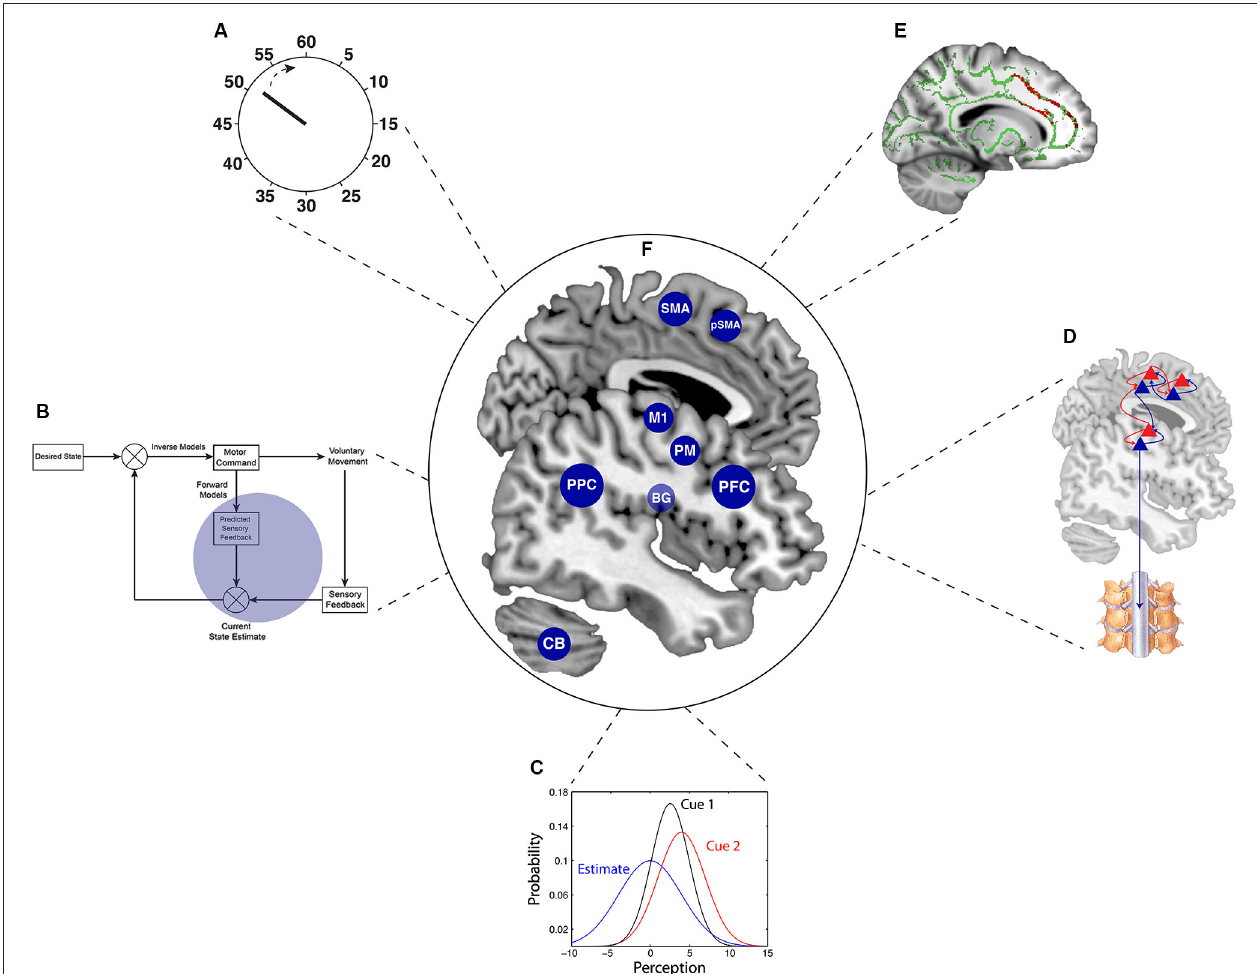
implementing Bayesian principles for voluntary action (enlarged in Figure 3 ). (E) Combination of structural and functional neuroimaging (inset adapted from Wolpe et al., 2014), which when considered together with these behavioral paradigms, provides a powerful tool for linking behavior to its underlying brain mechanisms. (F) The central brain illustration depicts the critical brain areas for voluntary action, which are alluded to in this Review. BG = basal ganglia; CB = Cerebellum; M1 = primary motor cortex; PFC = prefrontal cortex; PM = Premotor cortex; PPC = posterior parietal cortex; pSMA = pre-supplementary motor area; SMA = supplementary motor